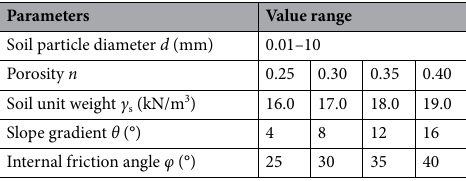
Table 7. Value range of the parameters for sensitivity analysis of the critical shear